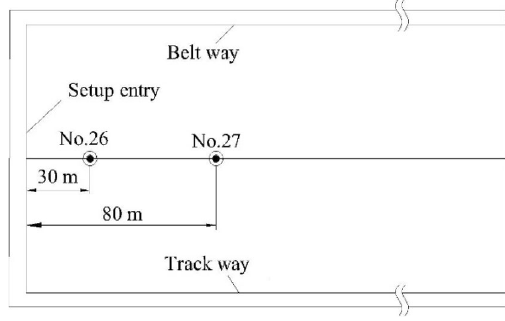
Fig. 6 Locations of the two boreholes in panel CT101